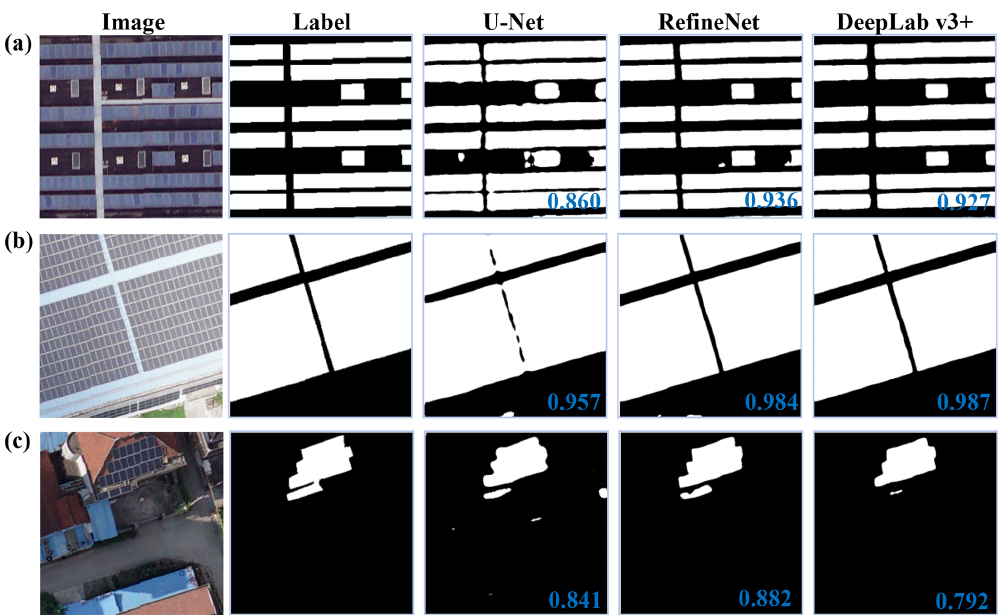
Figure 6. Segmentation results of PVs in PV01 dataset. Examples correspond to PVs on flat concrete (a) , steel tile (b) , and brick (c) roofs. IoU of each segmentation result is marked in blue within the image.